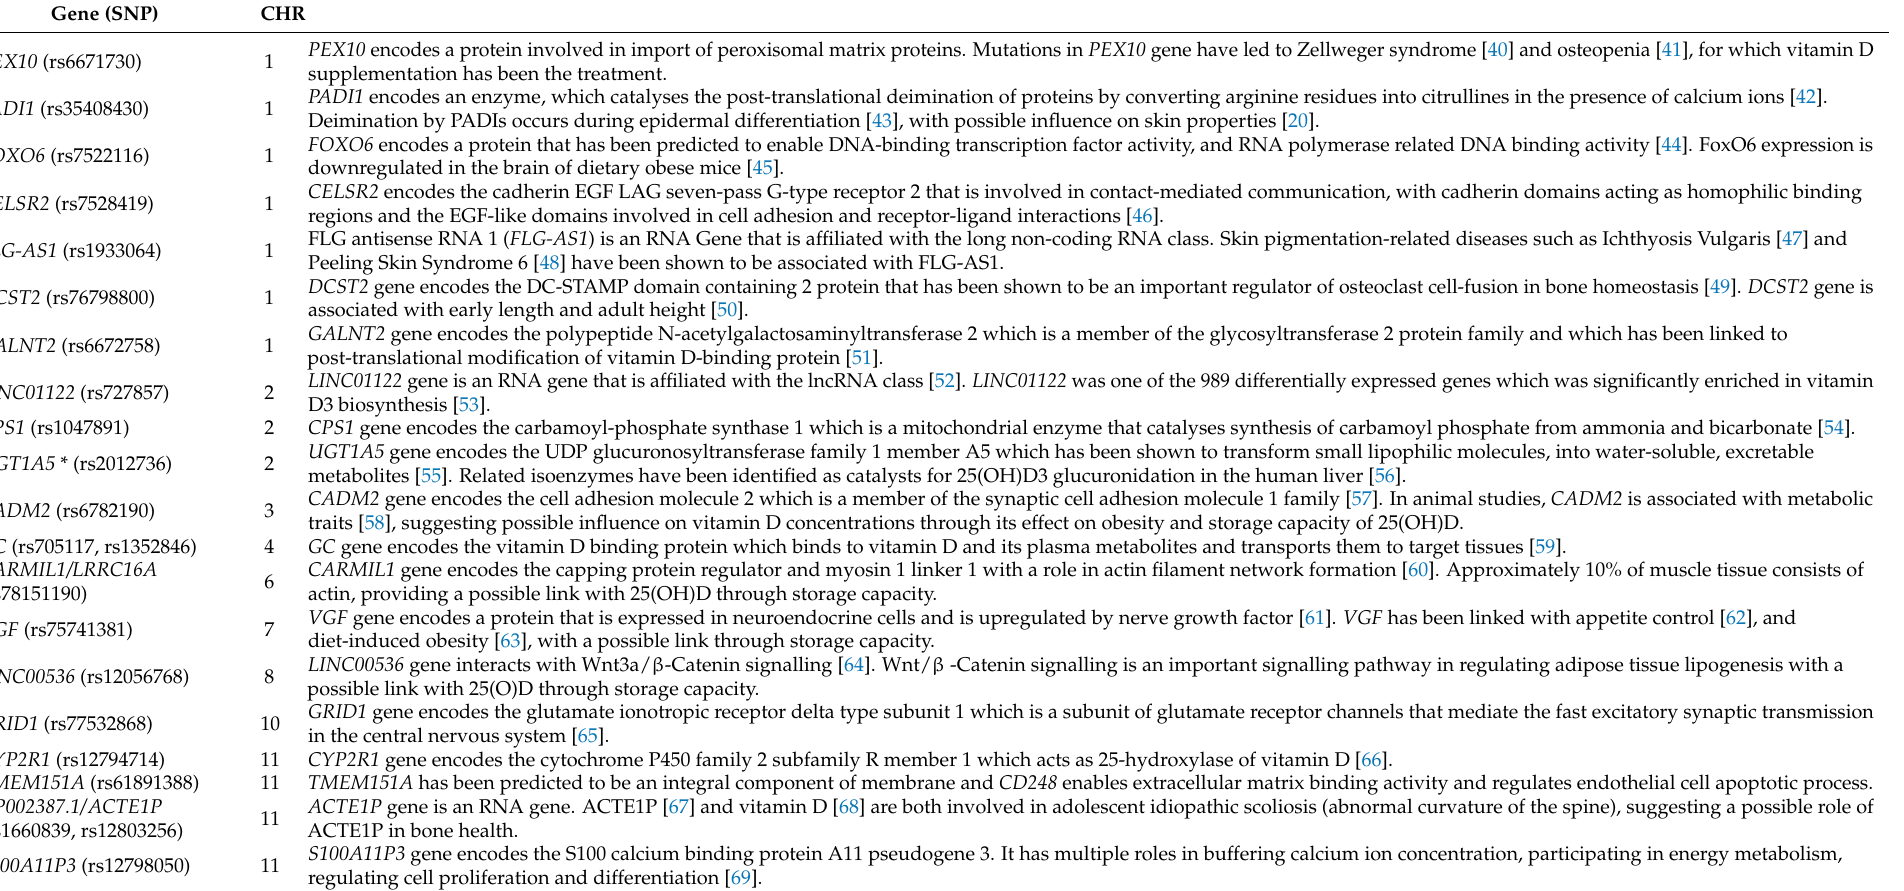
Table 1. Genetic variants with replicating evidence for an association with 25-hydroxyvitamin D